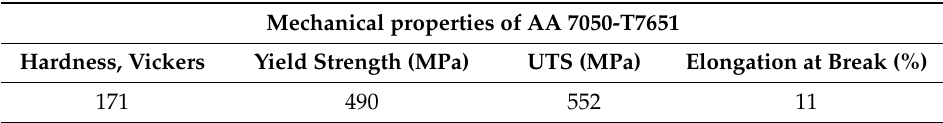
Table 2. Mechanical properties of the aluminium alloy AA7050-T7651.